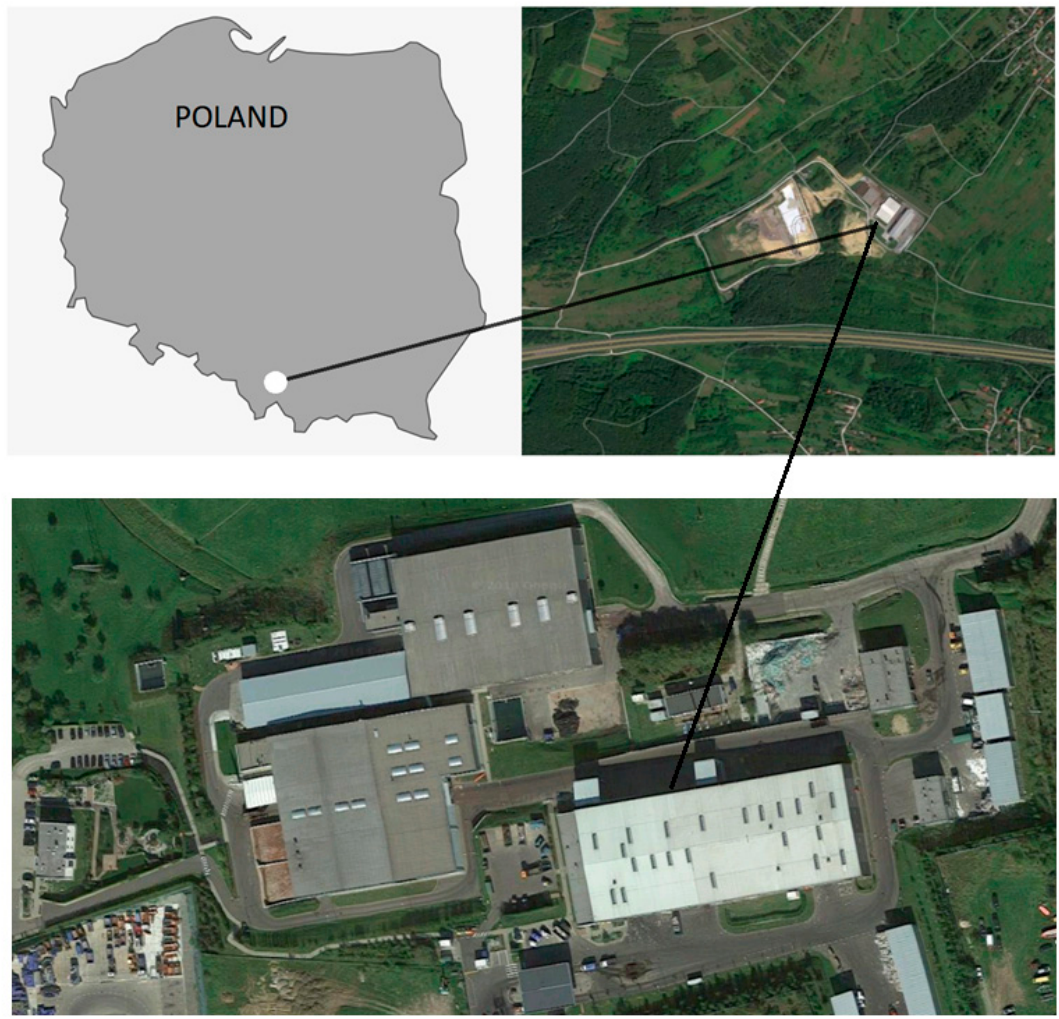
Figure 1. Sampling sites (map source: Google Earth).